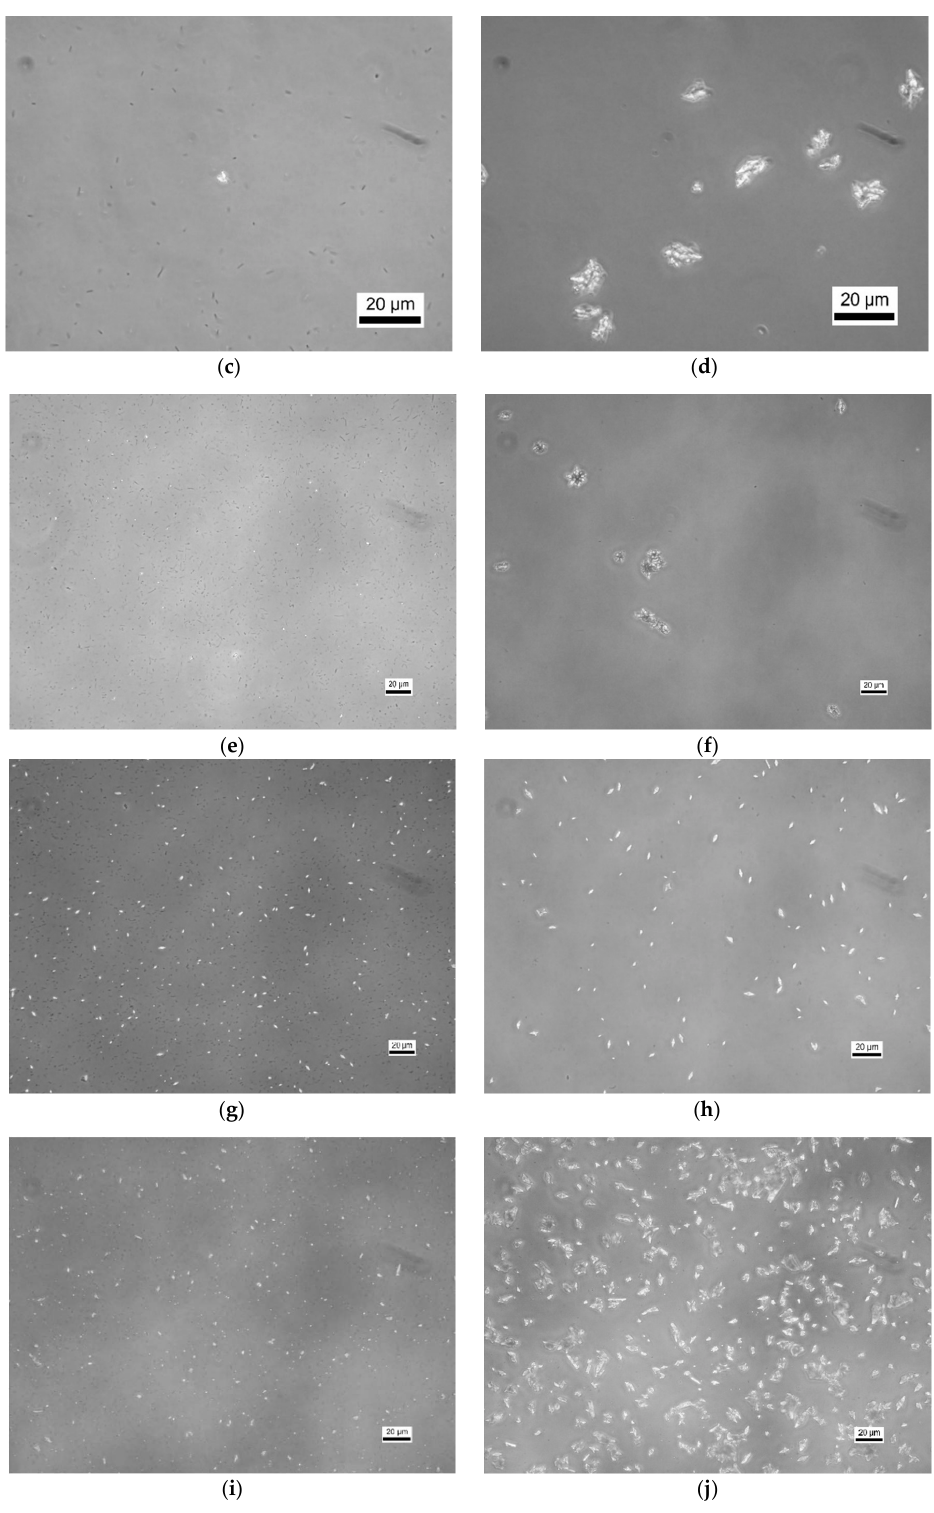
Figure A1. Light microscopy pictures of samples: top layer of the bottle ( a , c , e , g , i ) and bottom layer of the bottle ( b , d , f , h , j ) after 2 h of sedimentation. From top to bottom: Paper mill 1 ( a , b ), Landfill ( c , d ), Cadaver ( e , f ), Paper mill 2 ( g , h ), and Paper mill 3 ( i , j ).